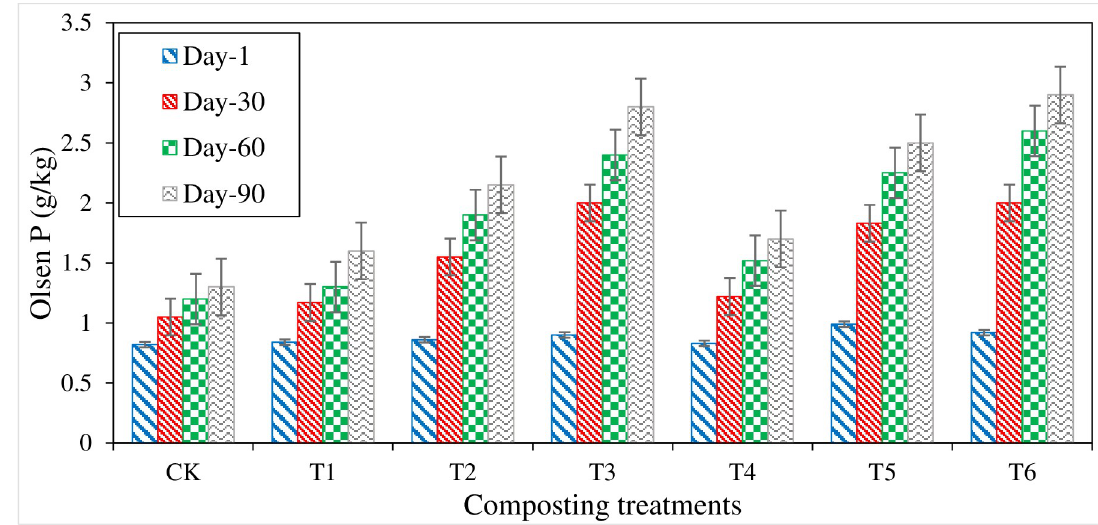
Fig 9. Variations in Olsen P measured from different composting